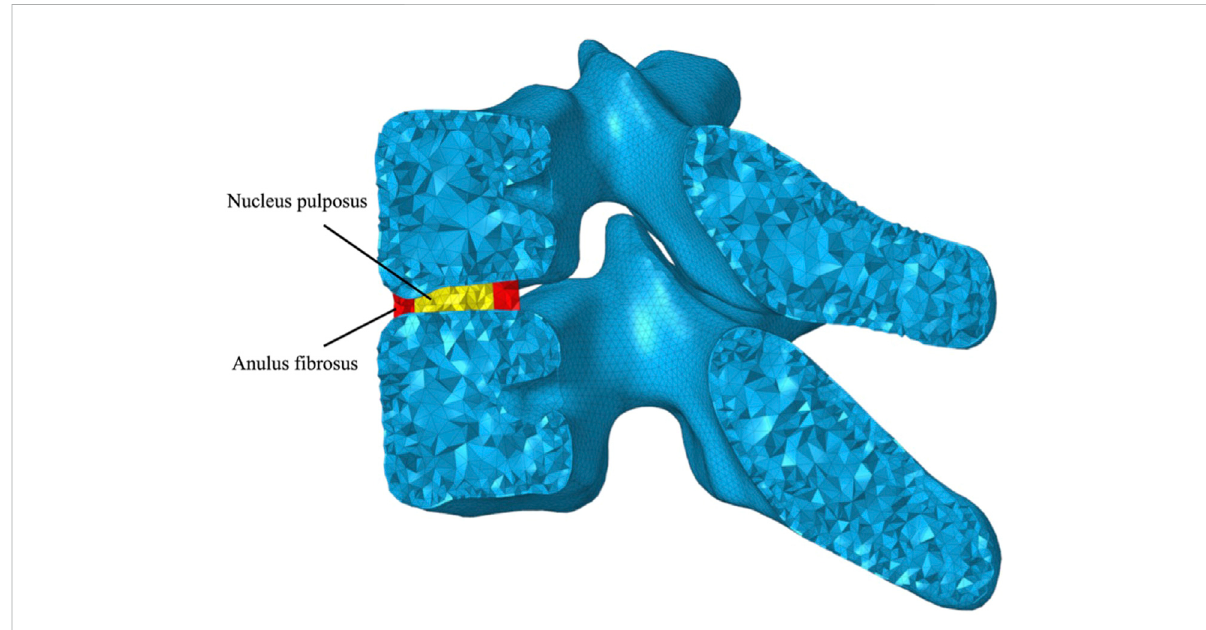
FIGURE 4 Graphical representation of the intervertebral disc (IVD) consisting of nucleus pulposus (NP) and anulus fi brosus (AF).